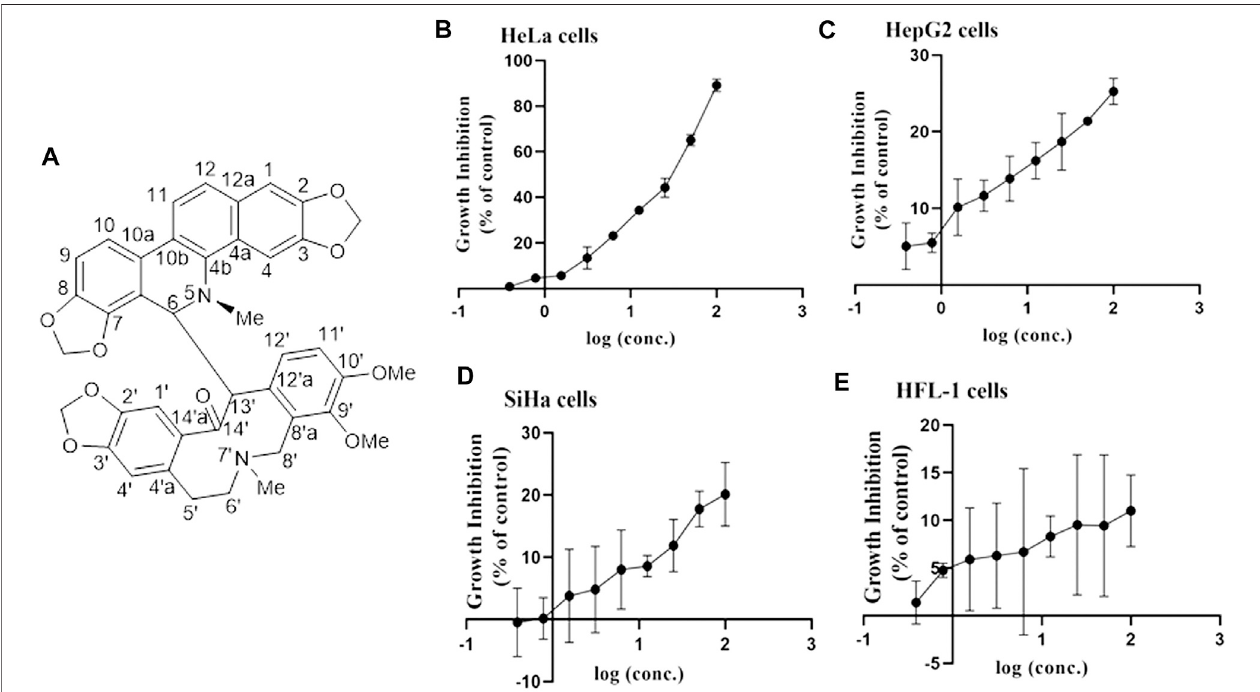
FIGURE 1 | Structure of MA and the association between inhibition of growth and MA concentrations on various cell lines. (A) Structure of MA. (B) HeLa cervical carcinoma cell line. (C) HepG2 liver carcinoma cell line. (D) SiHa cervical carcinoma cell line. (E) HFL-1 normal cell line. Each dot indicates the mean ± SD of triplicate experiments that were evaluated